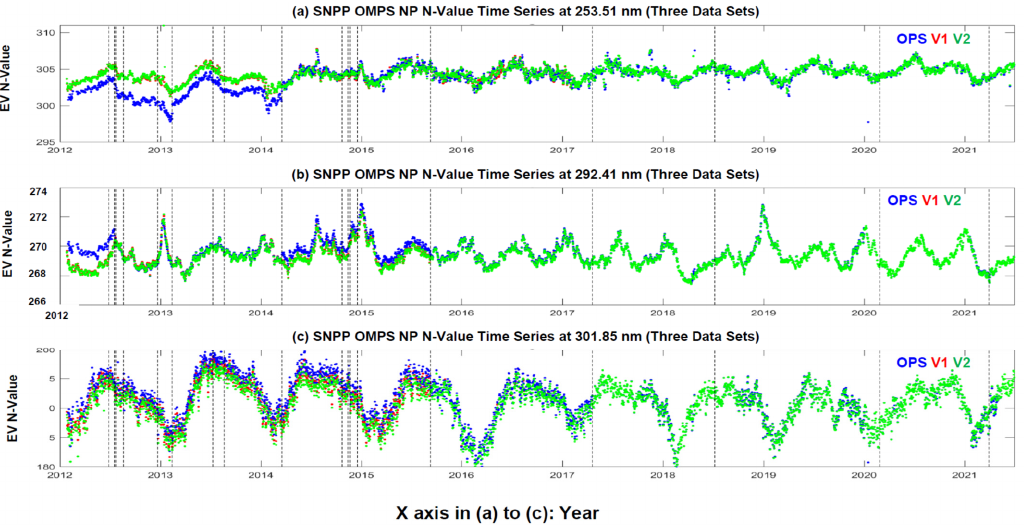
Figure 8. Same as Figure 6, except for the averaged N-value; ( a ) 253.51 nm, ( b ) 292.41 nm, ( c ) 301.85 nm.